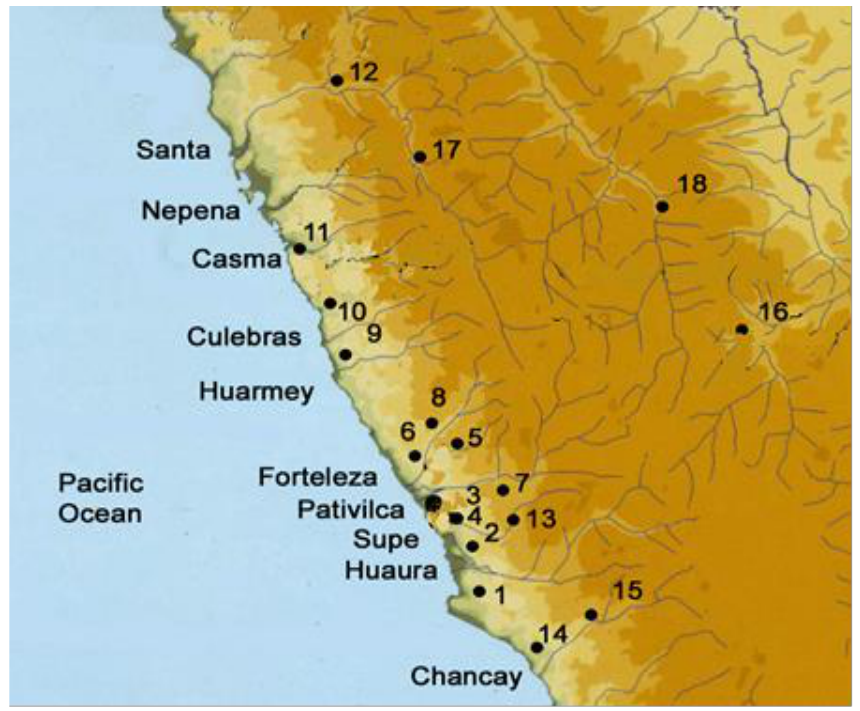
Figure 22. Location of Caral (13) in the Supe Valley on the north coast of Peru. Additional numbers indicated relate to other Preceramic, Formative, and Early Horizon sites in adjacent valleys. Color version of figure derived from [2], p. 224.